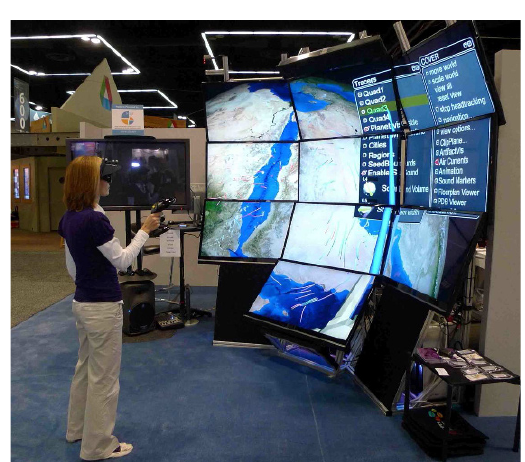
Figure 13. The 10-panel NexCAVE at the SC’09 conference show- ing content developed by Philip Weber. Photo: Tom De-